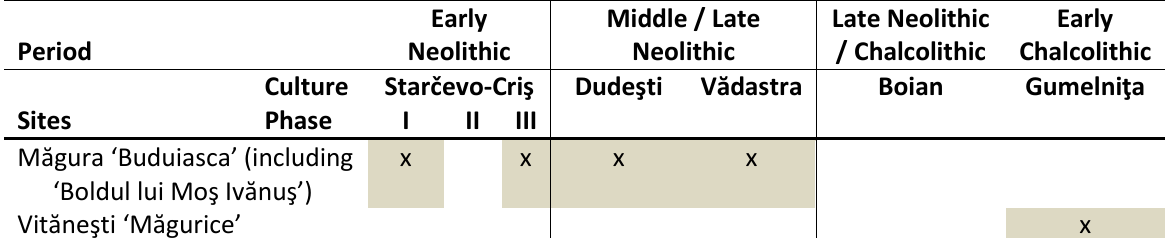
Table 1. Sites from Teleorman County indicating the cultures present at each (marked with an ‘x’). Note that none of the sites had Boian occupations. Ages according to (Andreescu 2006; Andreescu et al. 2008b; Mirea